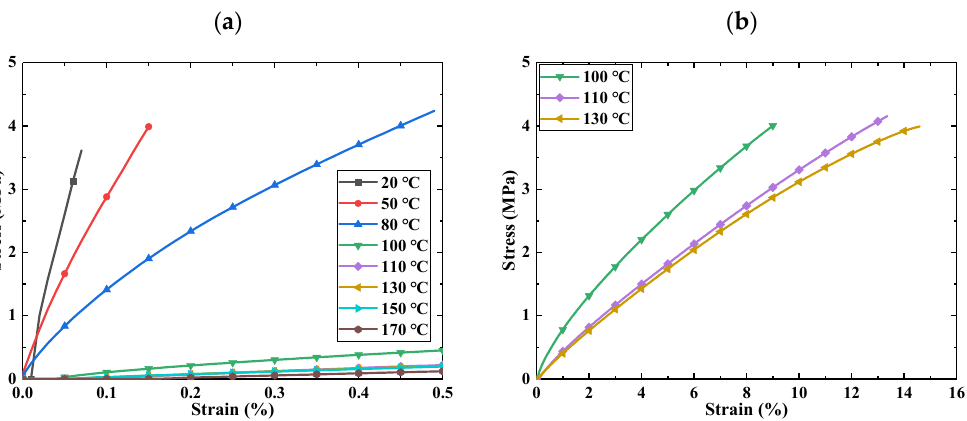
Figure 3. Tensile tests for E-SMP at different temperatures: ( a ) tensile characteristic curves of E-SMP at different temperatures; ( b ) tensile characteristic curves near the glass transition temperature.